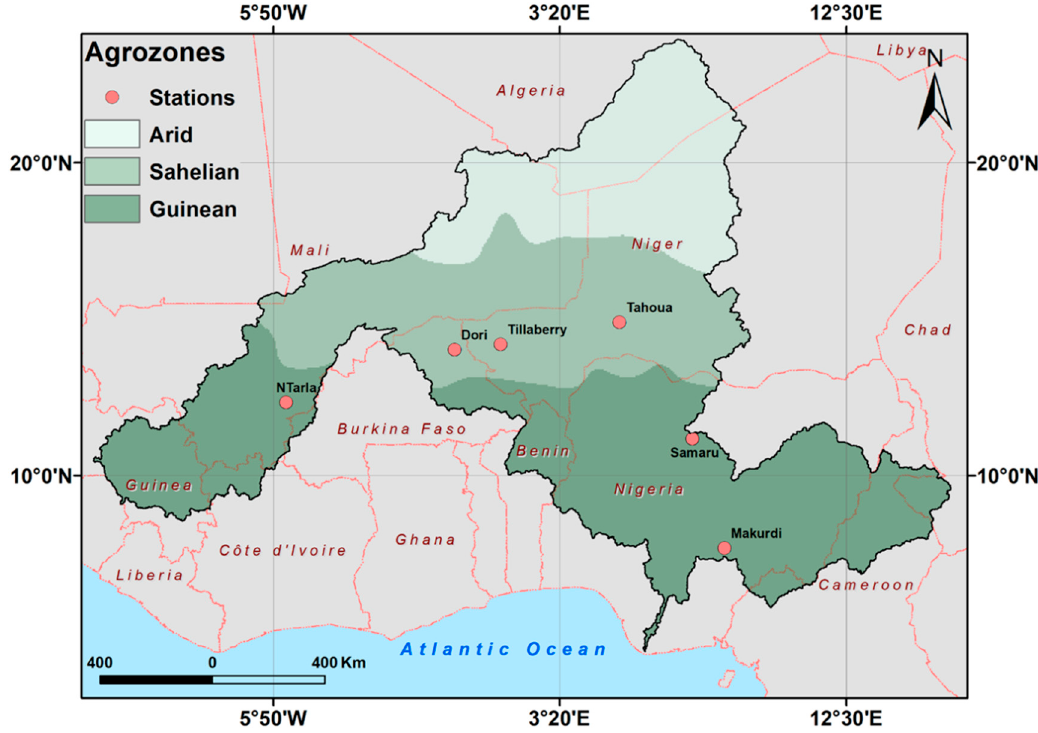
Figure 1. The Location of the Niger Basin in West Africa, showing study locations (red dots) and agro-ecological zones.